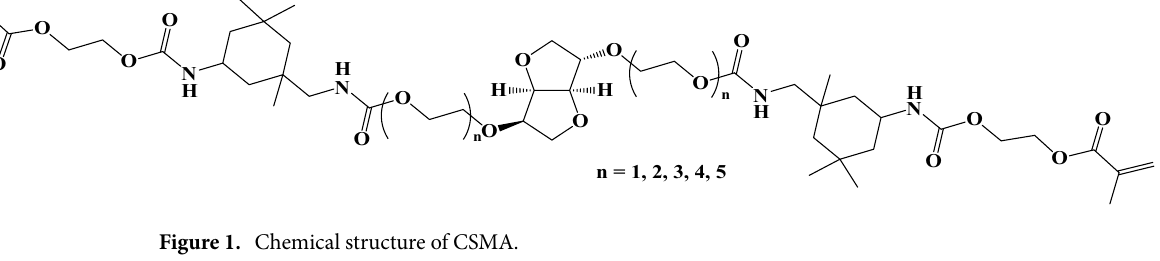
Figure 1. Chemical structure of